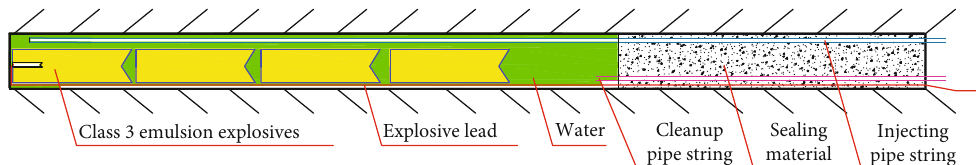
Figure 10: In-hole charge line connecting diagram.